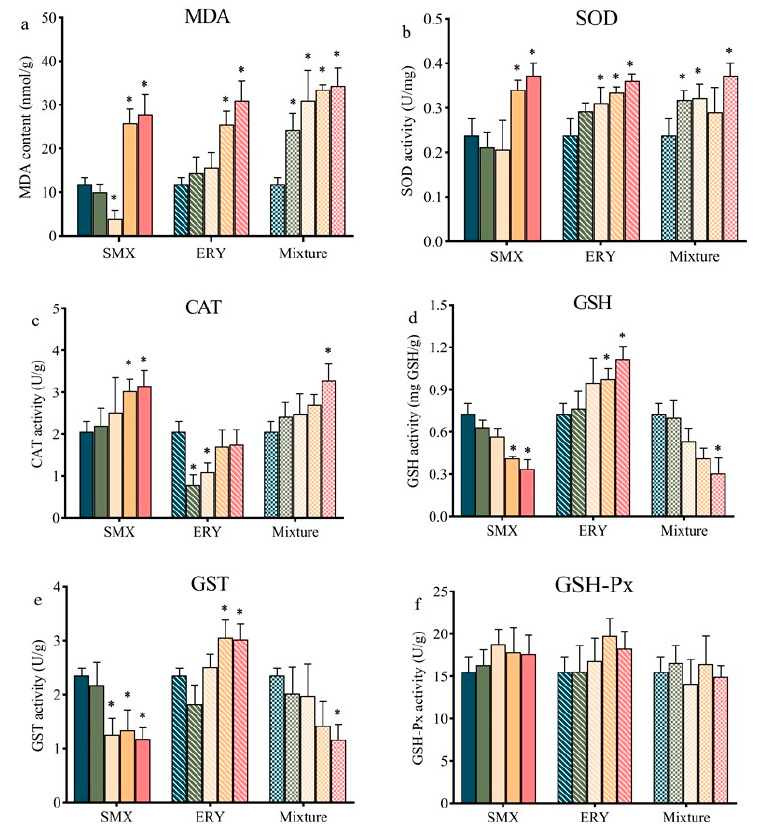
Figure 3. Contents of ( a ) malondialdehyde (MDA) and activities of ( b ) superoxide dismutase (SOD), ( c ) catalase (CAT), ( d ) glutathione (GSH), ( e ) glutathione S-transferase (GST), and ( f ) glutathione peroxidase (GSH-Px) in R. subcapitata after 11 days exposure to SMX, ERY, and their mixture. SMX (0, 0.1, 0.3, 0.5, and 0.7 mg/L), ERY (0, 0.01, 0.03, 0.05, and 0.07 mg/L), and their mixture (0, 0.011, 0.033, 0.055 and 0.077 mg/L in a ratio of SMX/ERY = 10:1). Data are presented as mean values ± standard deviation (n = 3). The asterisk (*) indicates a significant difference ( p < 0.05) between control and